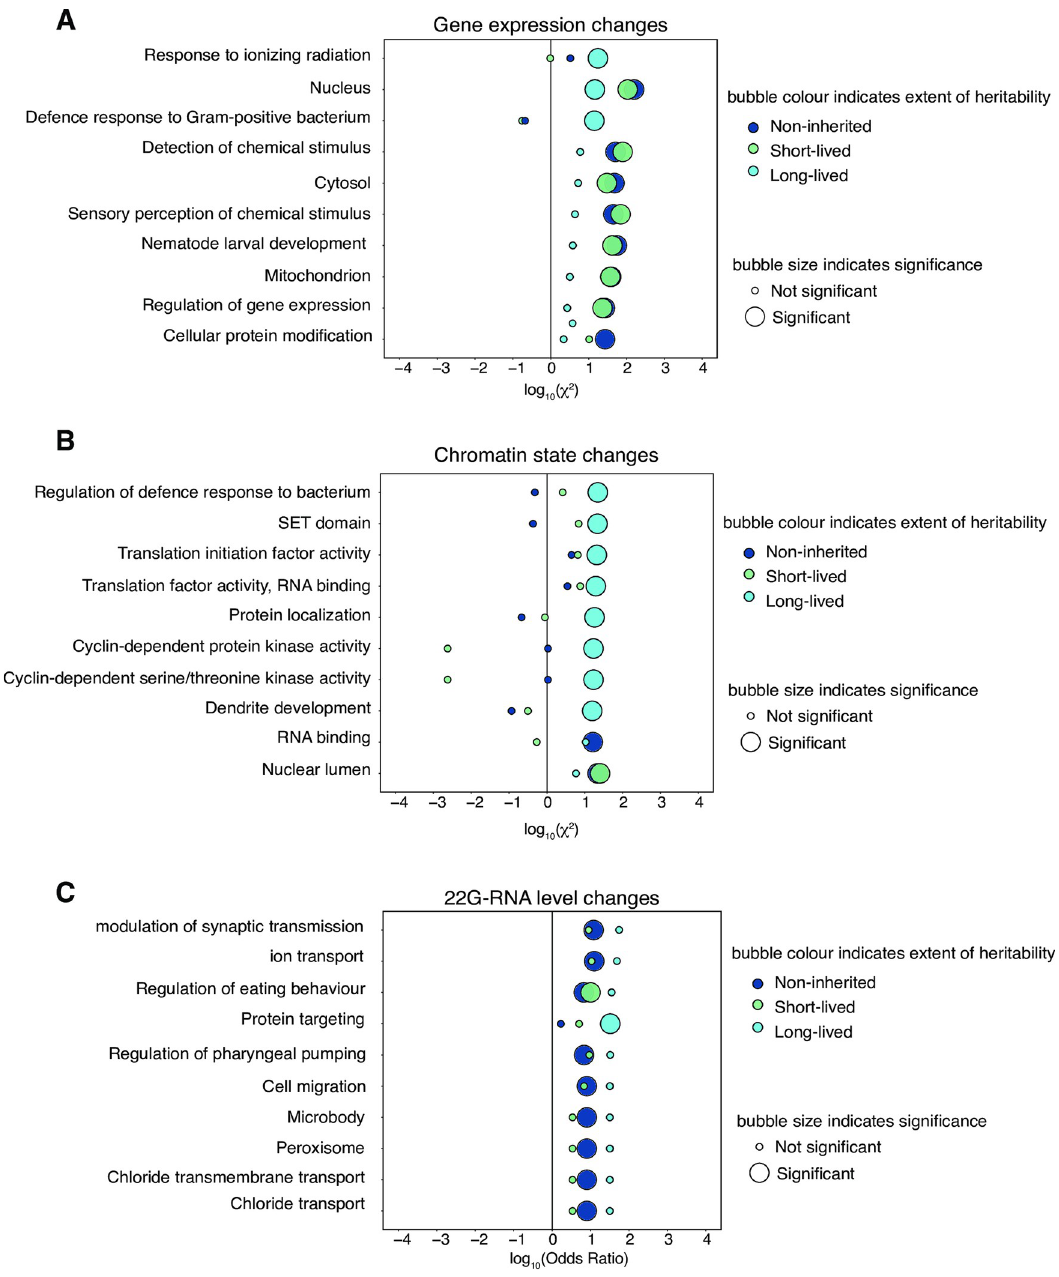
Fig 5. Genes with long-lived epigenetic changes are enriched for nematode defence functions. A. Bubble plot showing ontology term enrichment of genes with non-inherited (dark blue), short-lived (light green) and long-lived (light blue) expression changes compared to genes without expression changes. Enrichment calculated with χ -squared test, top 10 results shown. X-axis shows log 10 ( χ ) for enrichment. Y-axis shows ontology terms. B. Bubble plot showing ontology term enrichment of regulatory element loci with long-lived, short-lived and non-inherited chromatin-based epimutations compared to genes without chromatin-based epimutations. Enrichment calculated with χ -squared test, top 10 results shown. X-axis shows log 10 ( χ ) for enrichment. Y-axis shows ontology terms. C. Bubble plot showing ontology term enrichment of genes with long-lived, short-lived and non-inherited 22G-RNA-based epimutations compared to genes without 22G-RNA-based epimutations. Enrichment calculated using Fisher’s Exact Test with Bonferroni correction, top 10 results shown. X-axis shows log 10 (Odds) of enrichment. Y-axis shows ontology terms. For all plots, p-value cut off for significance is